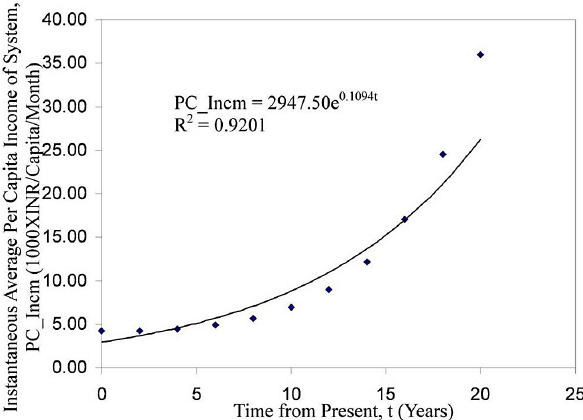
Figure 7. iThink model